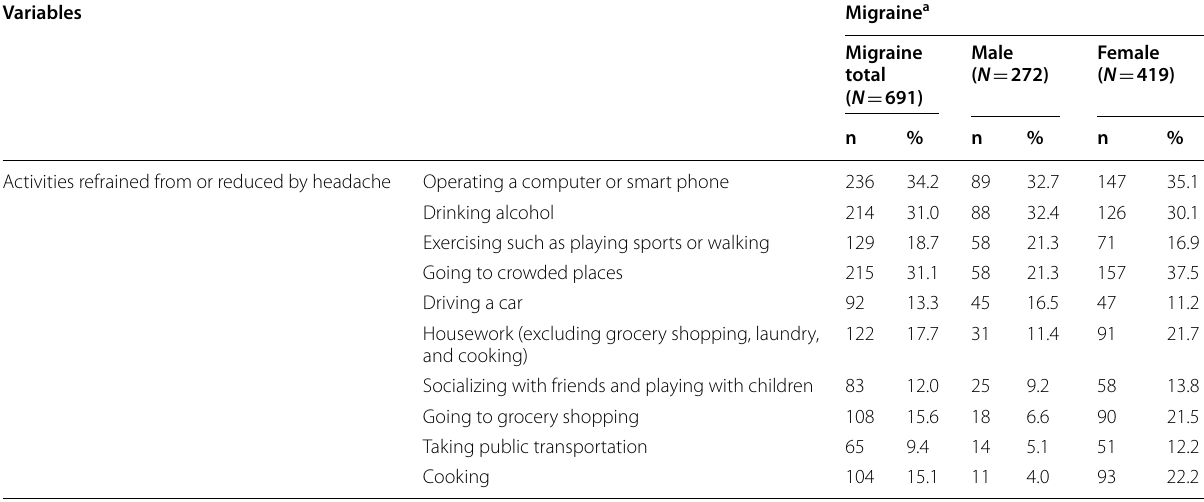
Table 5 Activities refrained from to reduce the frequency of headaches in people with migraine (stratified by